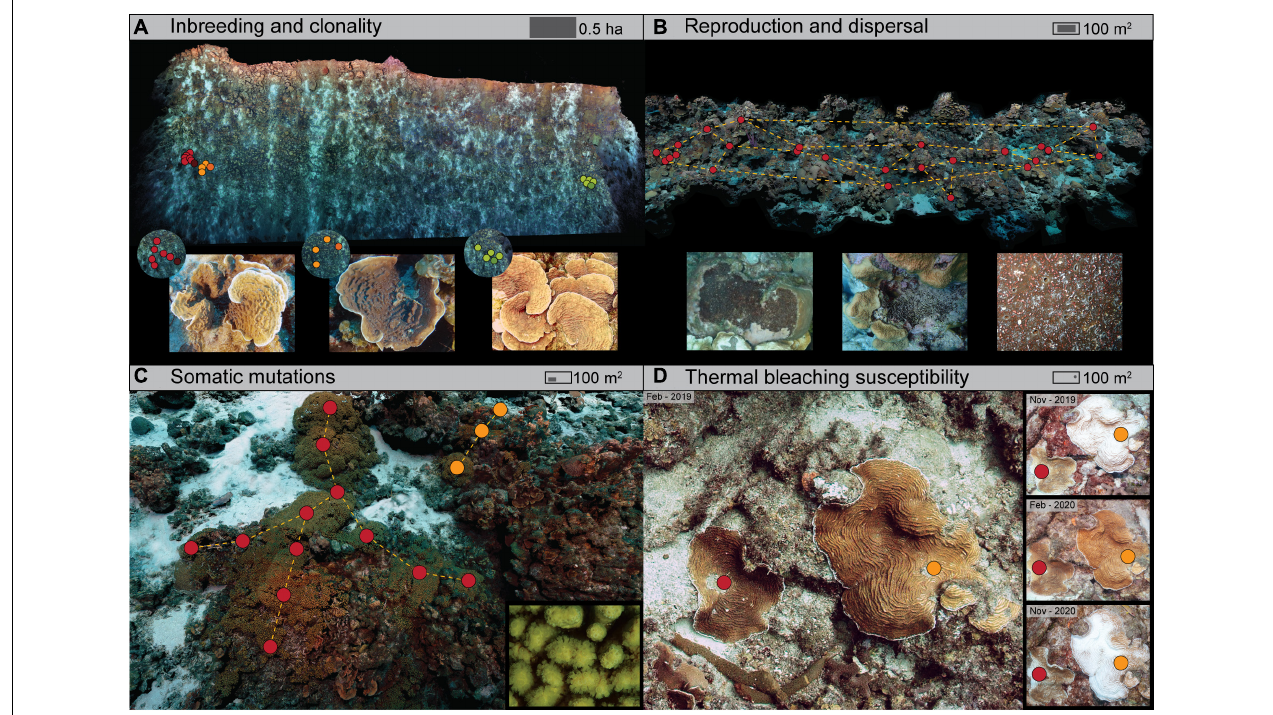
FIGURE 2 | Four example applications of reefscape genomics, conducted as part of the CoralScape project in Curaçao (Southern Caribbean). This project monitors large-area plots (0.5–1 ha per plot) and focal plots (100 m 2 ) covering a range of 5–60 m depth at eight different locations along the leeward shore. The focal plots are reimaged twice a year (using a Canon 5DsR with an EF 24 mm f1/4 prime lens and four Inon Z330 strobes) and incrementally sampled (for different taxa). Collected samples are referenced to the 3D model using video from a head-mounted camera, with the diver carrying a 96-well rack with numbered 0.5 mL tubes bungee-mounted to their forearm. (A) Broad-scale imaging ( > 0.5 ha per plot) to assess the impact of rapid population decline on the reproduction and genomic variation in the coral Helioseris cucullata , and to evaluate extinction risk and appropriate conservation strategies (Hernandez-Agreda et al., unpublished data). (B) Medium-scale imaging (100 m 2 per plot) to understand the roles of niche partitioning and asexual reproduction in the fast expansion of coral-eroding sponges in the Cliona viridis species complex (Achlatis et al., unpublished data). Inset photographs show different growth forms and a close-up. (C) Medium-scale imaging (100 m 2 per plot) to track the spread of somatic mutations in the coral Madracis mirabilis , and assess their contributions to genetic diversity in large monospecific stands (Bongaerts et al., unpublished data). (D) Medium-scale imaging (100 m 2 per plot) to disentangle the role of environment and genotype in bleaching response and the overall effect of bleaching on population genetic diversity within the coral genus Agaricia (Prata et al., unpublished data). Circles represent samples of target organisms (as depicted in close-up photos) colored by genotype (except for in B ).